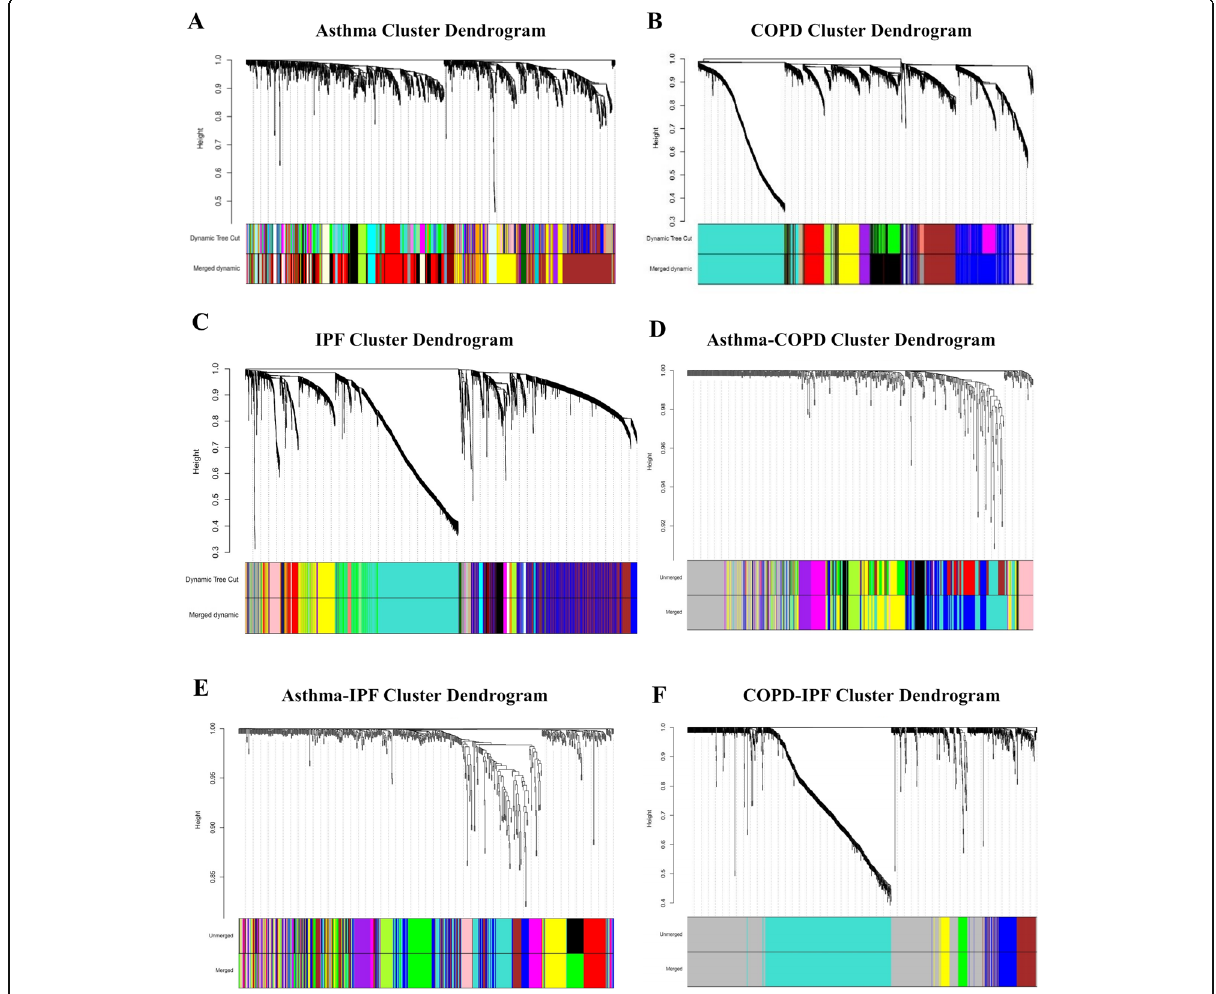
Fig. 3 The clustering dendrogram of genes. a Gene clustering situation in asthma data, b Gene clustering situation in COPD data, c Gene clustering situation in IPF data, d Gene clustering situation in the asthma-COPD data, e Gene clustering situation in the asthma-IPF data, and f Gene clustering situation in COPD-IPF